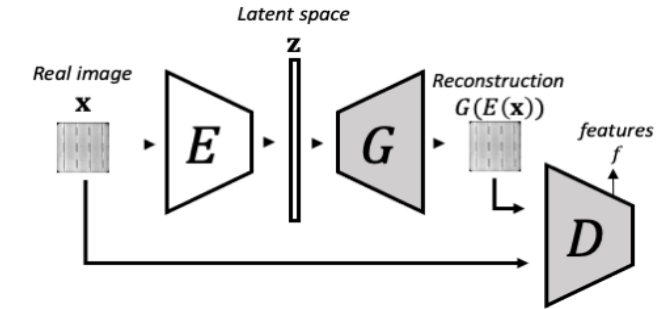
Figure 4. The schema of phase 2 of f-AnoGAN training. In the second phase, the Generator and Discriminator are kept unaltered while an Encoder is added and trained to learn to encode the images to the latent space so the Generator can reconstructed them back. This schema was inspired by the images from Schlegl et al.